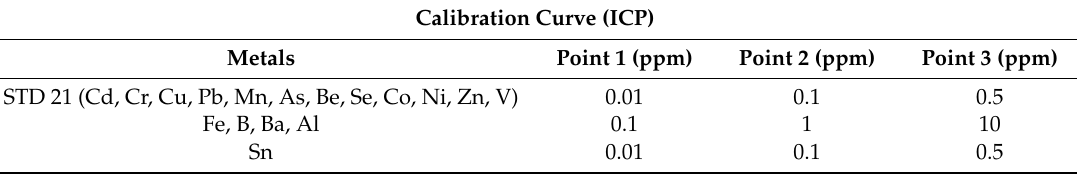
Table 1. Standard Calibration Curve Concentrations for metal composition analysis of water